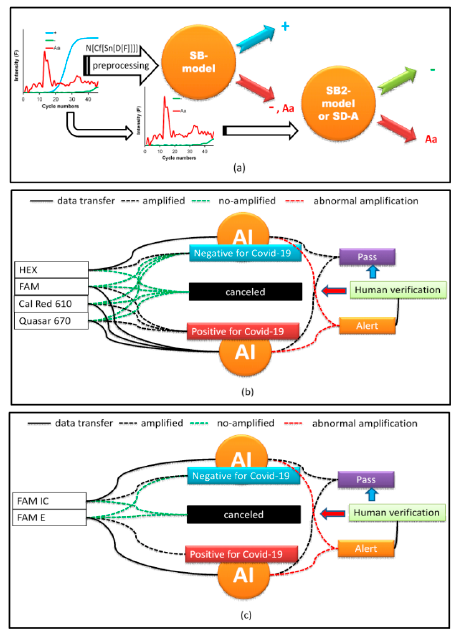
Figure 4. ( a ) Score plots of PC 2 vs. PC 1 for real-time RT-PCR curves for the diagnosis of SARS-CoV- 2 and their classification based on the S-Data-model; ( b ) scheme of the best preprocessing